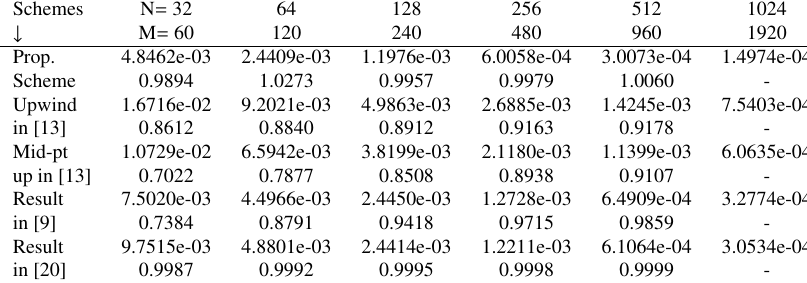
Table 4. Example 4.1, comparison of ε -uniform error and ε -uniform rate of convergence.